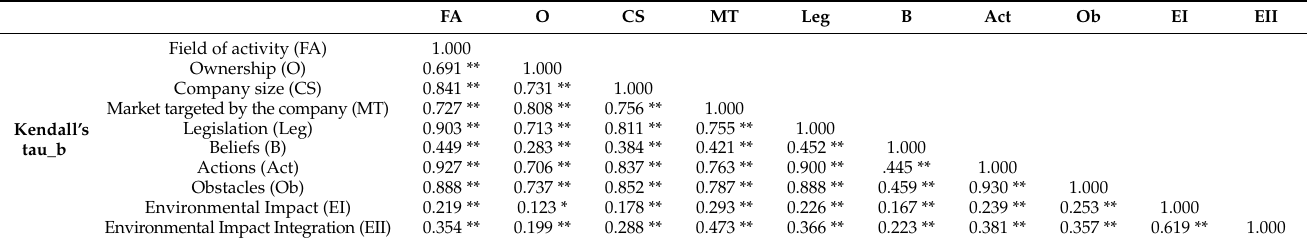
Table 8. Verification of Hypothesis